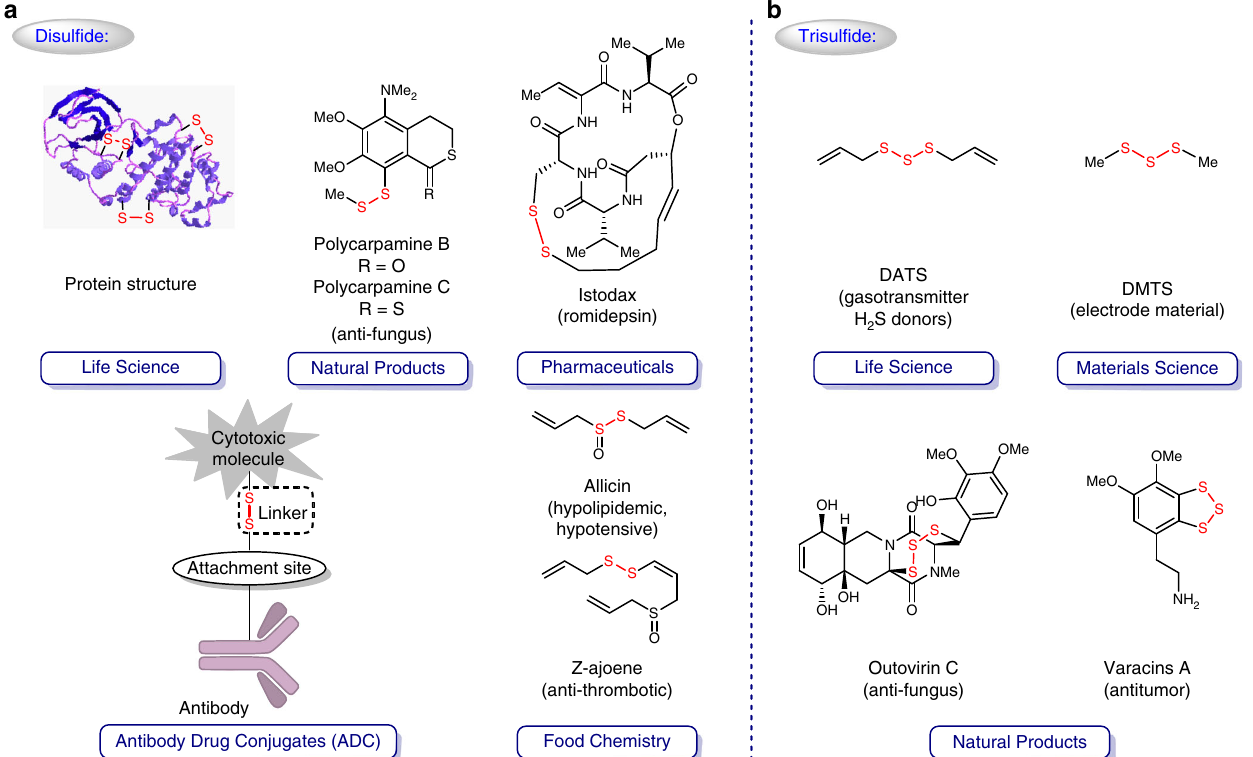
Fig. 1 Signi fi cant polysul fi des. a The importance of disul fi de scaffolds in life science, natural products, pharmaceuticals, antibody drug conjugates, and food chemistry. b Functional trisul fi de